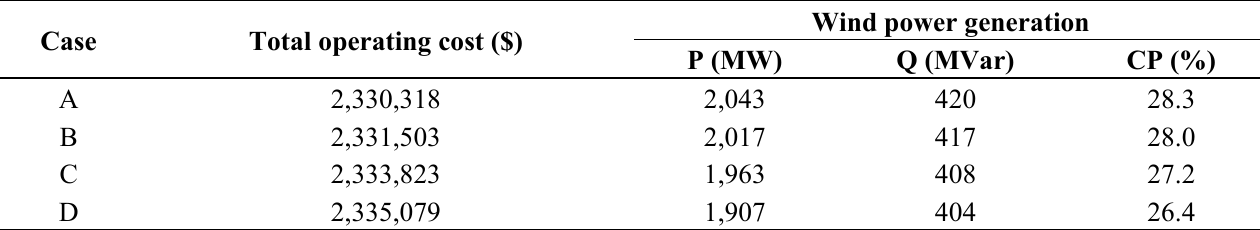
Table 5. Wake effect on P-OPF solutions.